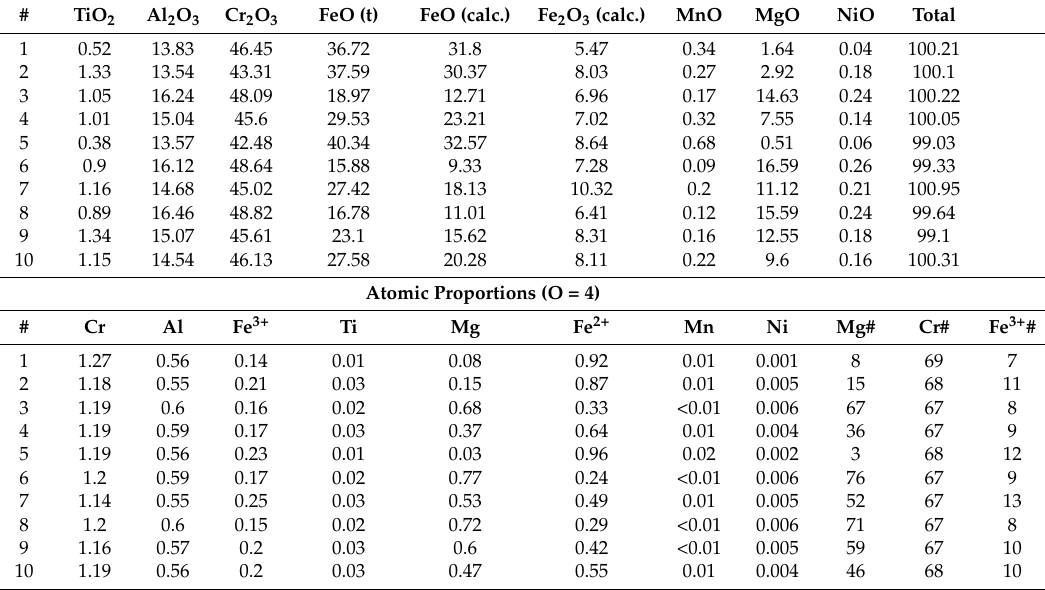
Table 1. Compositions of grains of magnesiochromite–chromite from the Sisim placer zone, Eastern Sayans,